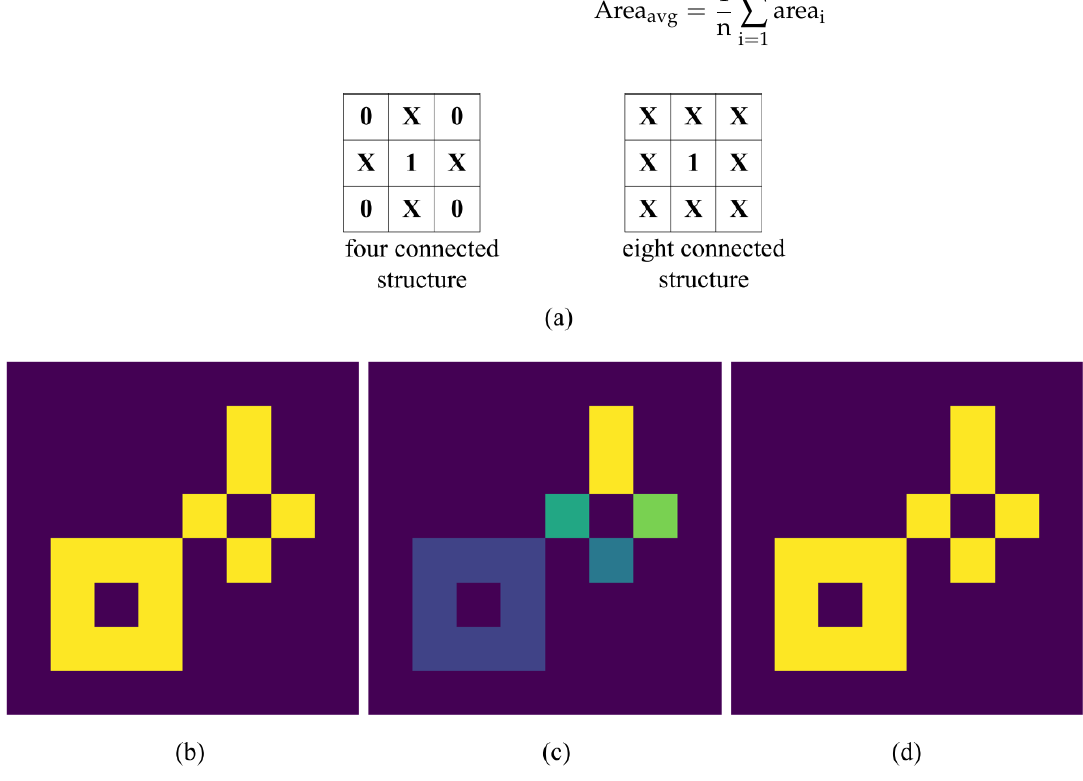
Figure 6. A simple example for the Connected Component Analysis for the image. ( a ) the four-connected structure and eight-connected structure. ( b ) An example image for connected component analysis. ( c ) The result after analysis with a four-connected structure. ( d ) The result after analysis with an eight-connected structure.